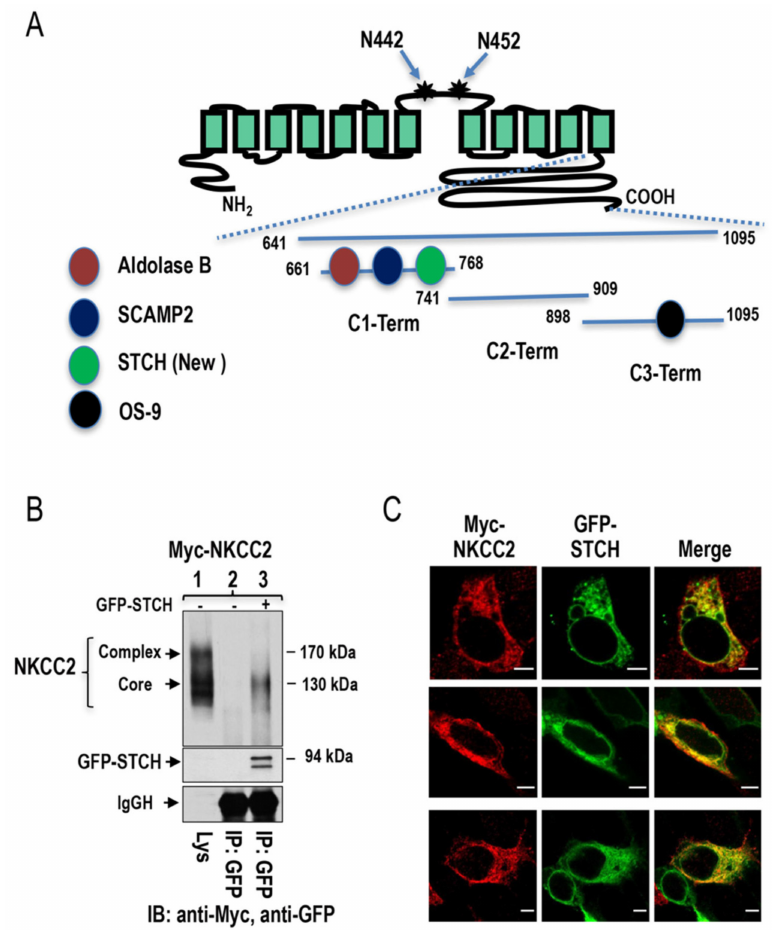
Figure 1. Identification of STCH as a novel NKCC2-interacting protein. ( A ) Mouse NKCC2 yeast two- hybrid baits constructs. A proposed topology for sodium-coupled chloride co-transporter NKCC2. N442 and N452 are the potential N -glycosylation sites. As previously described, mouse NKCC2 C terminus was divided into three peptide fragments (C1-term, C2-term, and C3-term) used as baits for the yeast two-hybrid. Similar to Aldolase B [39] and SCAMP2 [40], STCH interacts with C1-term while OS9 binds to C3-term [28]. ( B ) NKCC2 binds, in vivo, to STCH in HEK cells. HEK cells transiently transfected with Myc-NKCC2 singly or in combination with GFP-STCH were immunoprecipitated (IP) with anti-GFP anti-body ( lanes 2 and 3 ). 5% of total cell lysate (Lys) was resolved as positive control. Co-immunoprecipitated NKCC2 and STCH proteins were detected by immunoblotting (IB) using anti-Myc ( lane 3 ) and anti-GFP respectively ( lane 3 ). IgGH, the heavy chain of IgG. The positions of immature (core glycosylated) and mature (complex-glycosylated) proteins of NKCC2 are indicated. The interaction of NKCC2 with STCH involves mainly the immature form of the co-transporter. ( C ) Imunofluorescence confocal microscopy showing distribution of Myc-NKCC2 and GFP-STCH in HEK cells. Fixed and permeabilized cells were stained with mouse anti-Myc for NKCC2 (Texas Red). The yellow color (merged image) indicates co-localization of the proteins. Bars, 5 µ